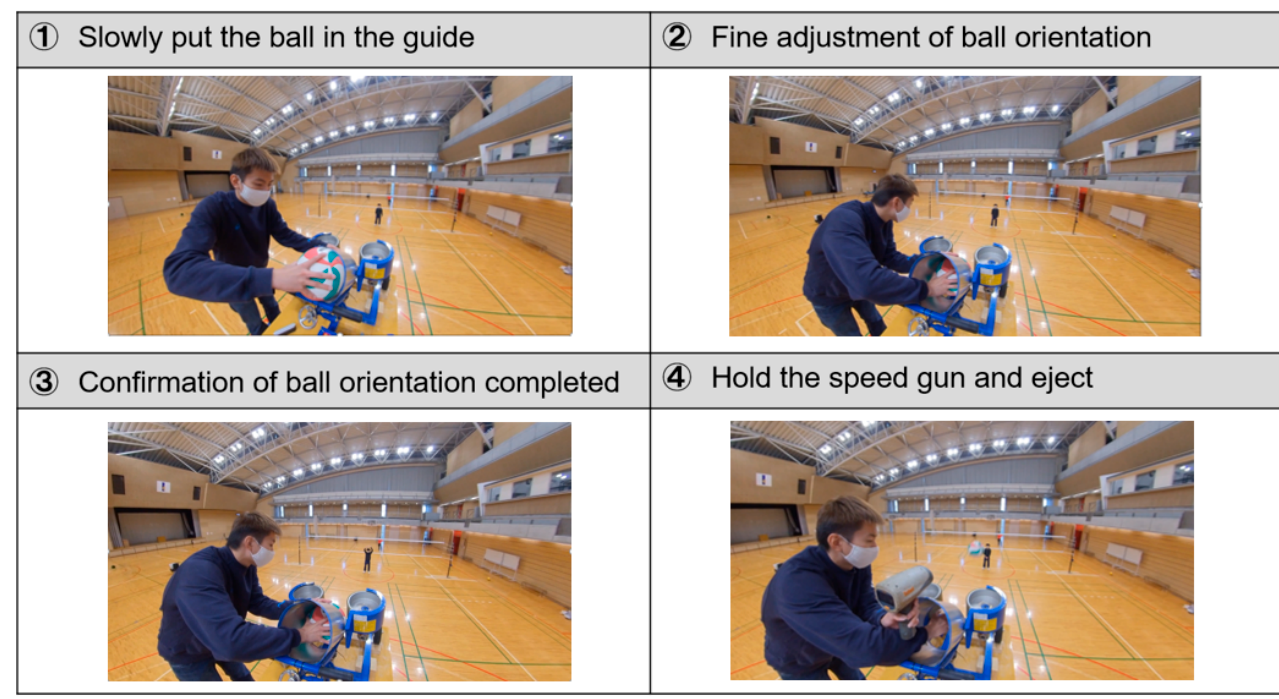
Figure 4. Ejection Figure 4. Ejection procedure .